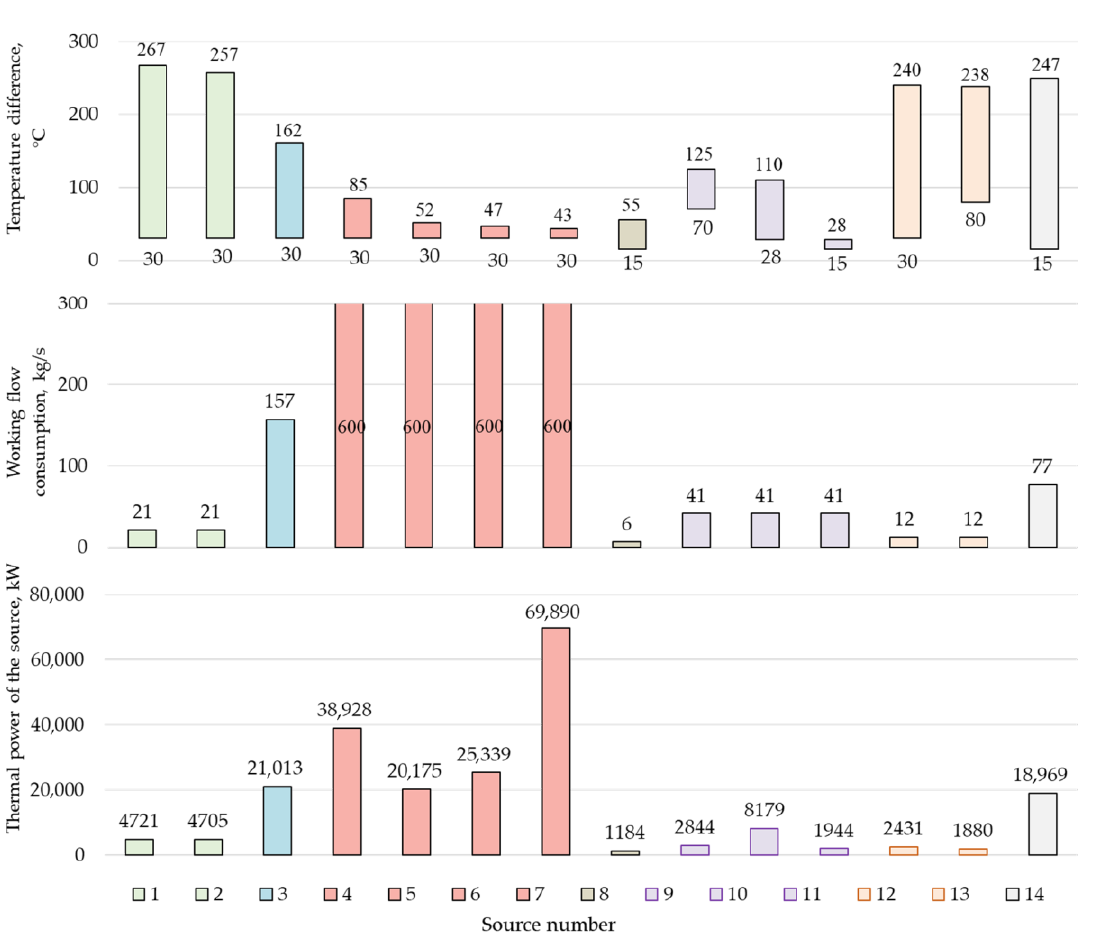
Figure 4. Thermal potential of the Allam cycle low-grade heat source, as follows: 1—intermediate cooler of the O 2 compressor first stage for the combustion chamber (CC); 2—intermediate cooler of the second stage of the O 2 compressor for the CC; 3—air cooler in front of the ASU; 4—intermediate cooler of the first stage of the CO 2 compressor; 5—intermediate cooler of the second stage of the CO 2 compressor; 6—intermediate cooler of the third stage of the CO 2 compressor; 7—CO 2 flow cooler in front of the carbon dioxide pump; 8—heat loss with H 2 O; 9—intercooler of CO 2 disposal compressor; 10—CO 2 flow cooler before disposal; 11—heat losses with CO 2 disposal; 12—intermediate cooler of the O 2 compressor for gasification; 13—O 2 flow cooler before gasification; 14—heat loss to the environment with the exhaust gases of the nitrogen gas turbine unit (GTU).